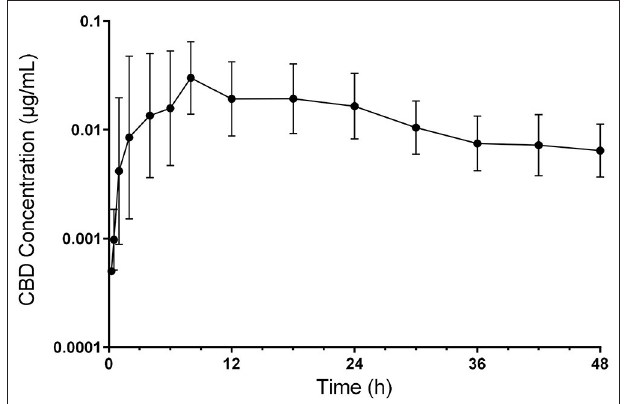
FIGURE 1 | Semilogarithmic transformation of geometric mean plasma concentration (with 95% confidence interval) of CBD following oral administration at 5